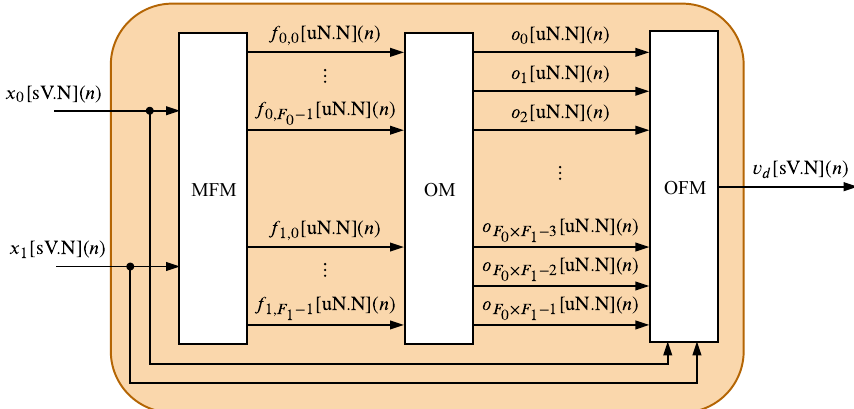
Figure 4. Hardware architecture of TS-FIMM One-Shot (TS-FIMM-OS).